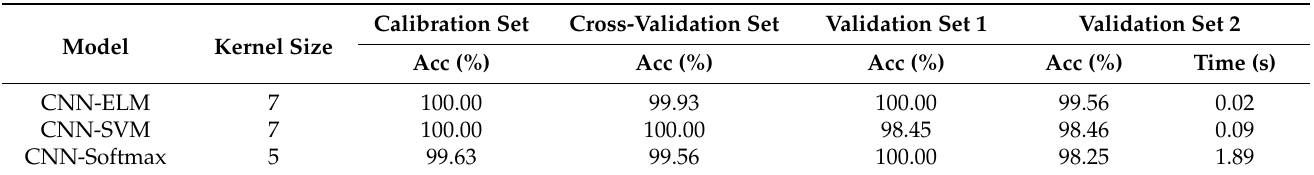
Table 1. Performance of the CNN-Softmax, CNN-ELM, and CNN-SVM models based on mean spectral information per direction with the best kernel